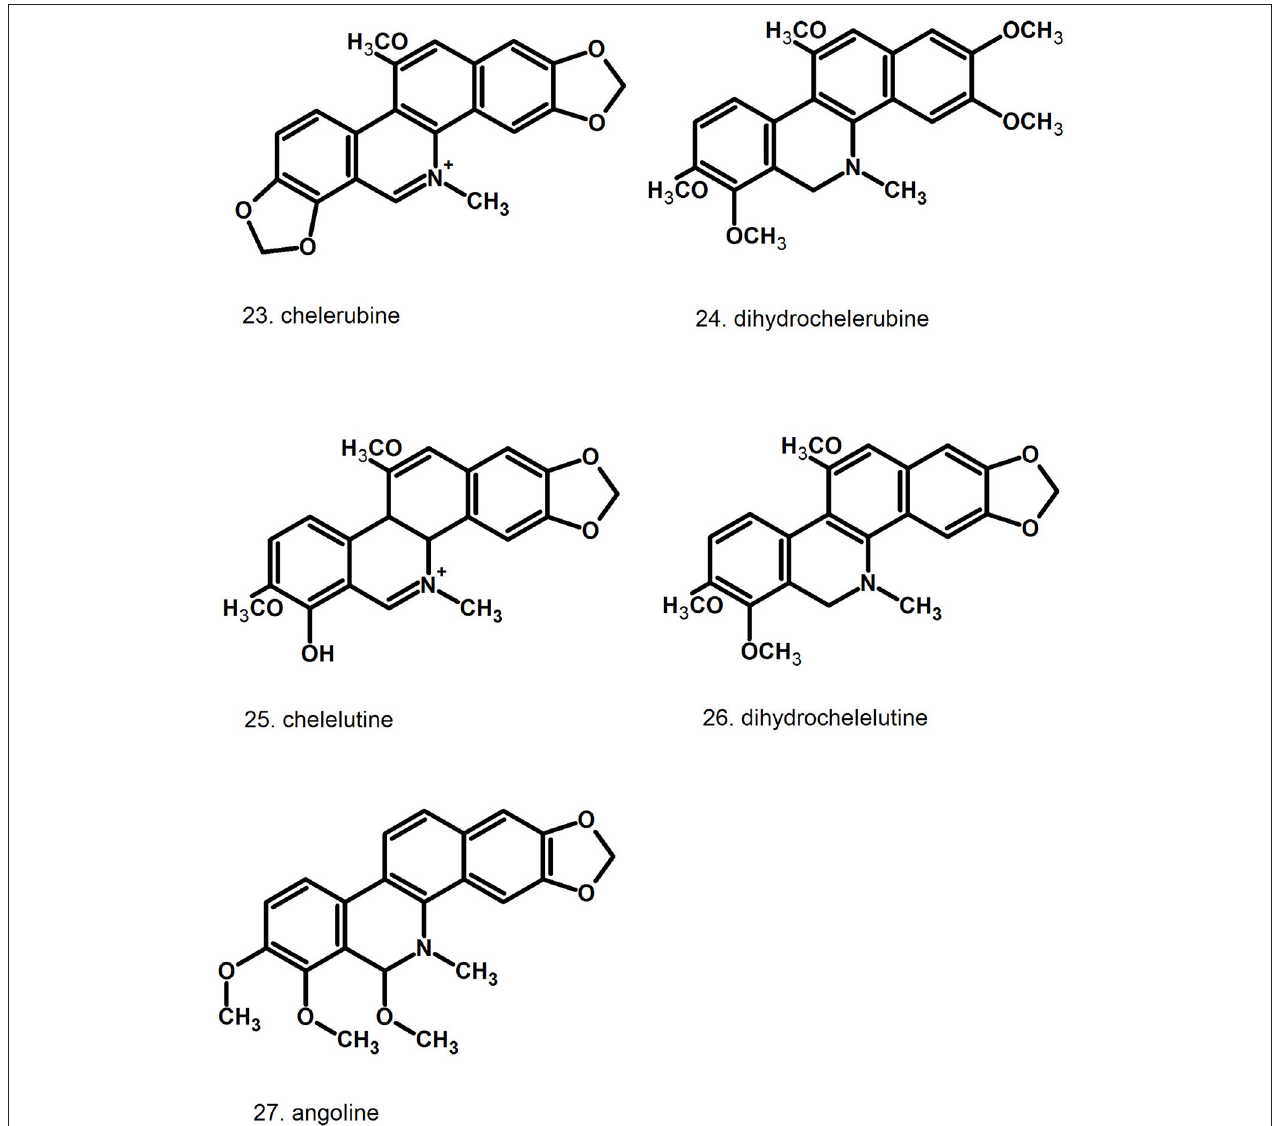
FIGURE 4 | Further structures of minor phenanthridine (3,4-benzoisoquinoline)